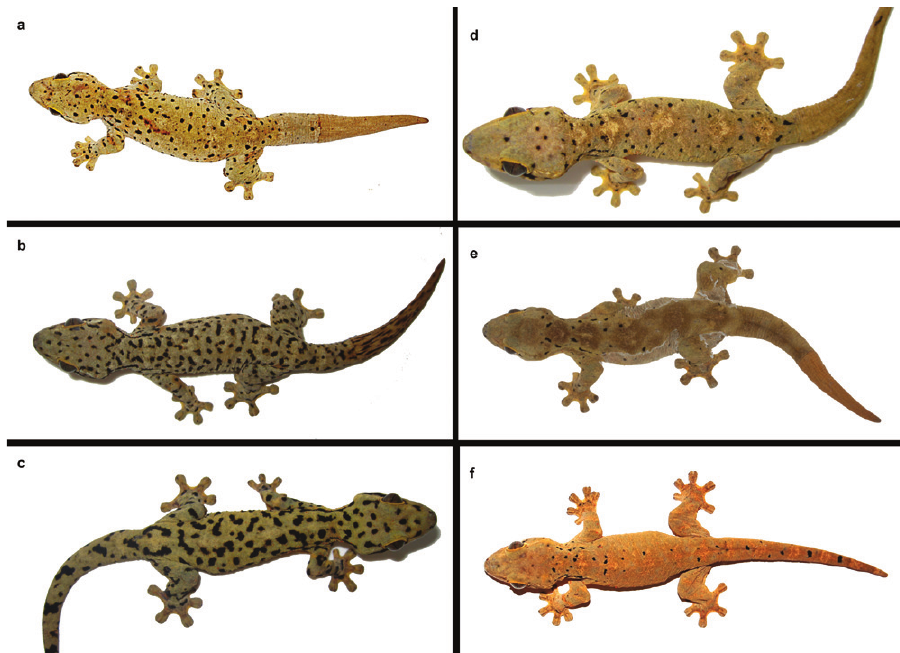
Figure 4. Thecadactylus oskrobapreinorum in life (specimens not preserved; all from Sint Maarten, Lesser Antilles). Photos a,e by Gunther Köhler; b,c,d by Stephan Prein, f by Maciej Oskroba